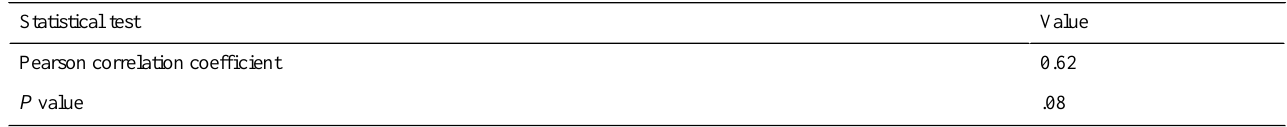
Table 2. Summary of statistical calculations for 9 virtual test subjects. a